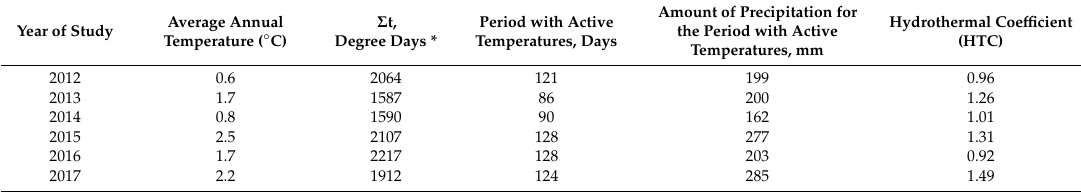
Table4. Temperatureregimeandhumificationconditionsinthesub-taigazoneaccordingtoobservations made at the Tomsk weather station, 56 ◦ 29’ N, 84 ◦ 56’